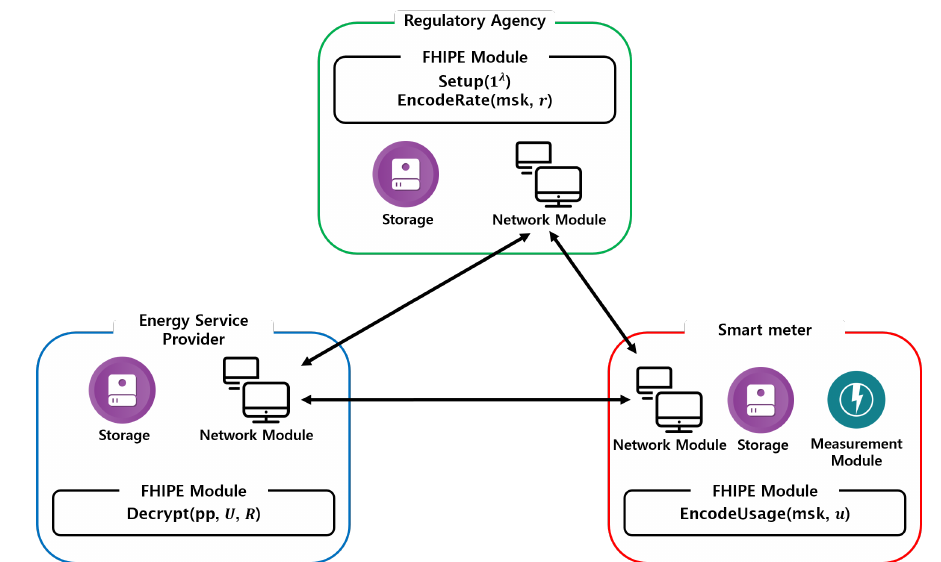
Figure 4. Component modules of proposed system.